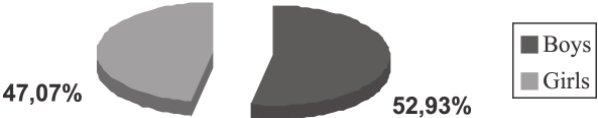
Figure 2 - Distribution of the total number of children that participate in this multicenter study according to their gender.